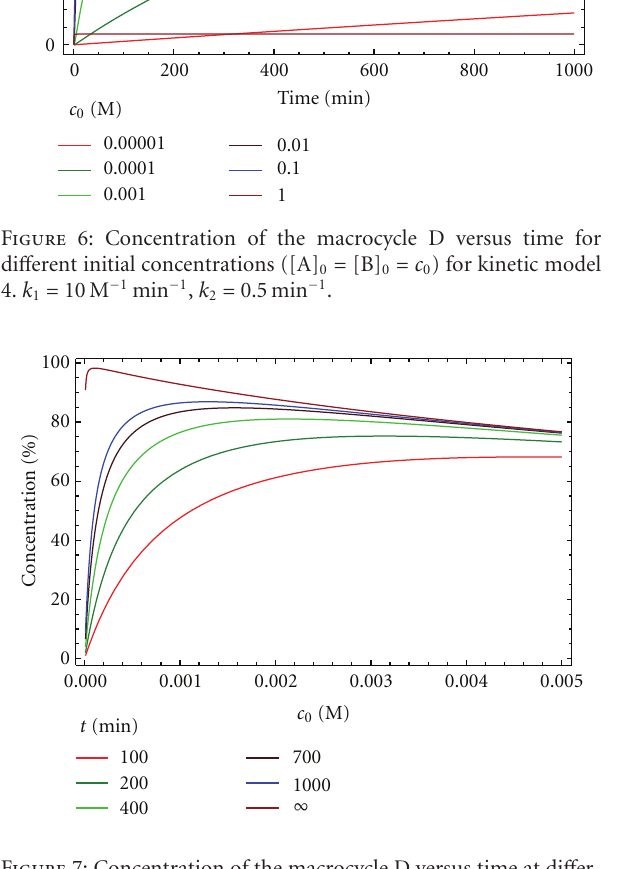
Figure 7: Concentration of the macrocycle D versus time at di ff er- ent reaction times ([A] 0 = [B] 0 = c 0 ) for kinetic model 4. k 1 = 10M − 1 min − 1 , k 2 = 0.5 min − 1 .